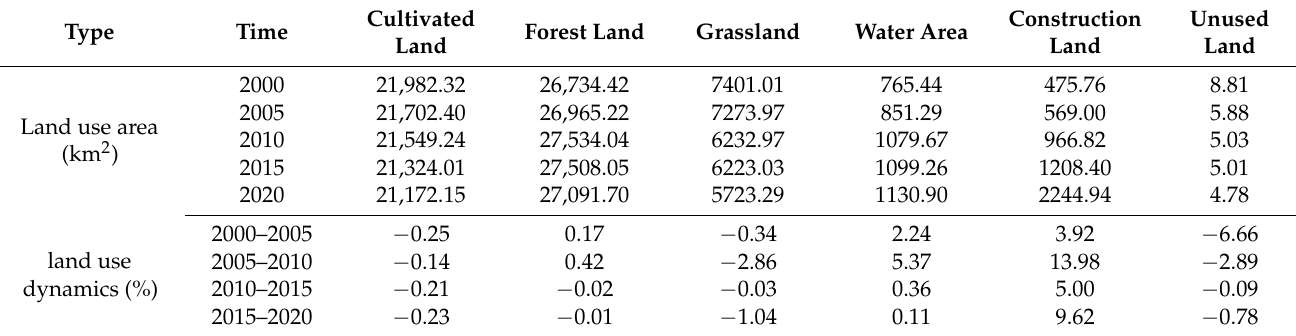
Figure 2. Spatial distribution of land use types from 2000 to 2020 (( a ) 2000, ( b ) 2005, ( c ) 2010, ( d ) 2015, ( e ) 2020). Table 3. Area and dynamic degree of land use types from 2000 to